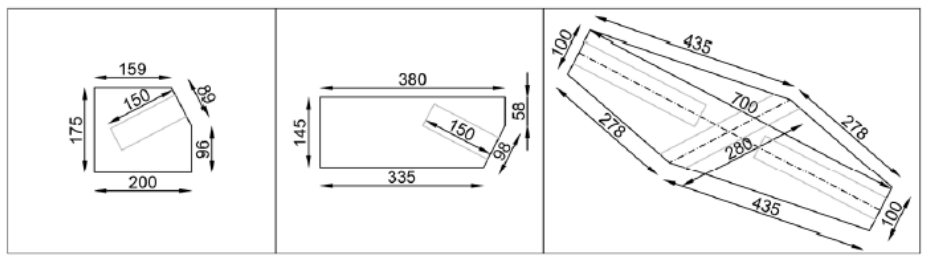
Figure 7. Details of connection plates (in order: base, top and diagonal intersection; measurements in mm). Table 2. Geometric and mechanic features of the steel profiles used in the test.